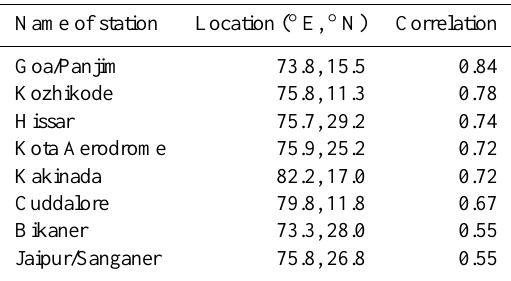
Table 1. Correlations between gauge rainfall and VCD.